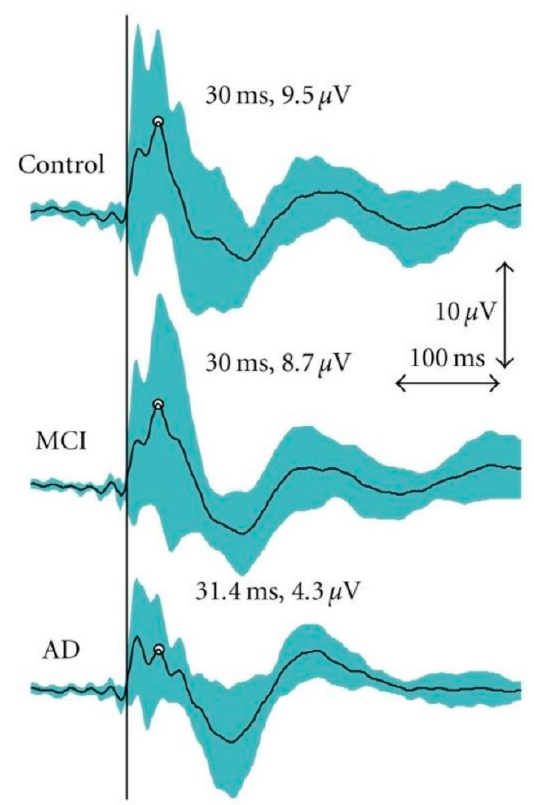
Figure 2. Grand average curves for transcranial magnetic stimulation (TMS)-evoked electroen- cephalography (EEG) responses as measured from the central electrode (CZ). The mean peak for the P30 has been indicated. However, P30 was analysed for individuals from the electrode chosen based on the shortest latency and clearest identification on the stimulated hemisphere. The turquoise area represents the 95% confidence interval for the TMS–EEG responses. The vertical black line indicates the moment of stimulation. Reproduced with permission from Julkunen et al., 2011